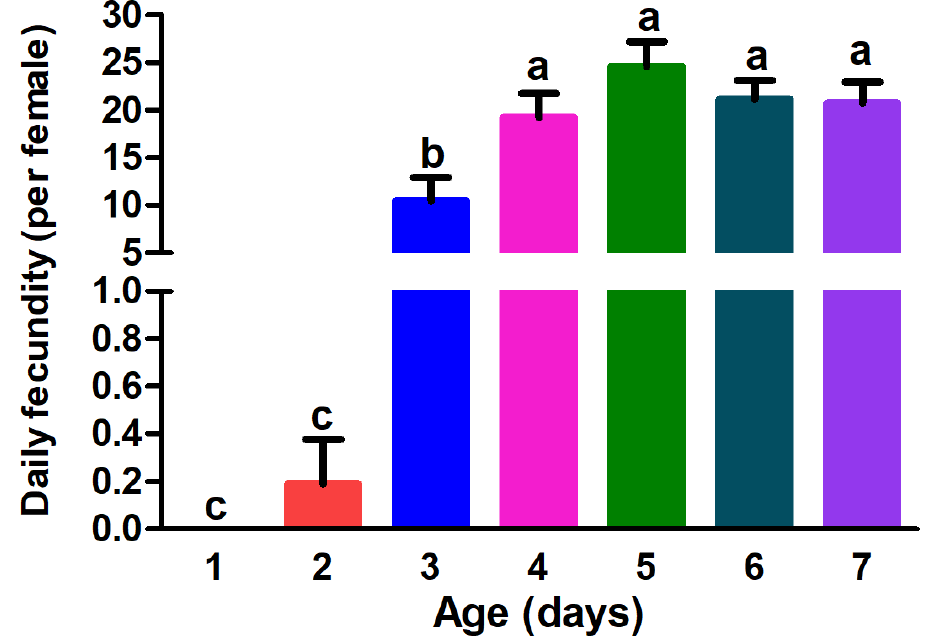
Figure 3. The fecundity of Grapholita molesta females of different ages. The data are shown as the mean ± standard error. The different lower-case letters indicate significant differences between the fecundity of females of different ages (ANOVA: HSD test, p < 0.05).